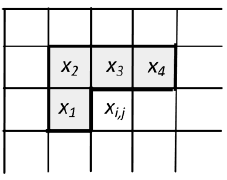
is the casual template